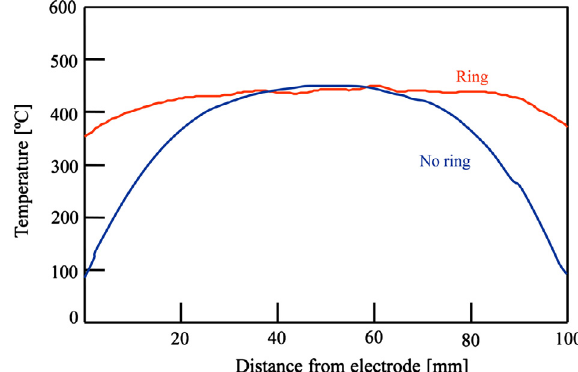
Table 2. Thermal conductivity and electrical resistance of stainless steel and copper. Figure 13. Distributions of temperature with and without stainless ring for maximum temperature of 450 (cid:3) C for J = 76 A/mm 2 Stainless steel